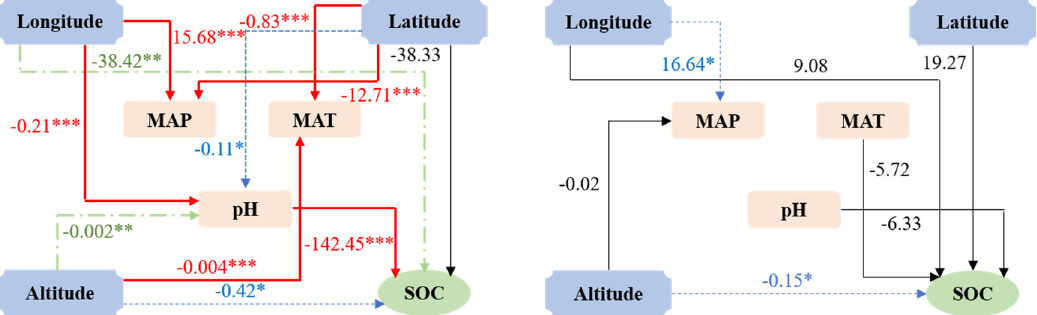
Figure 6. SEMs, representing hypothesized causal relationships between SOC content and physio- chemical